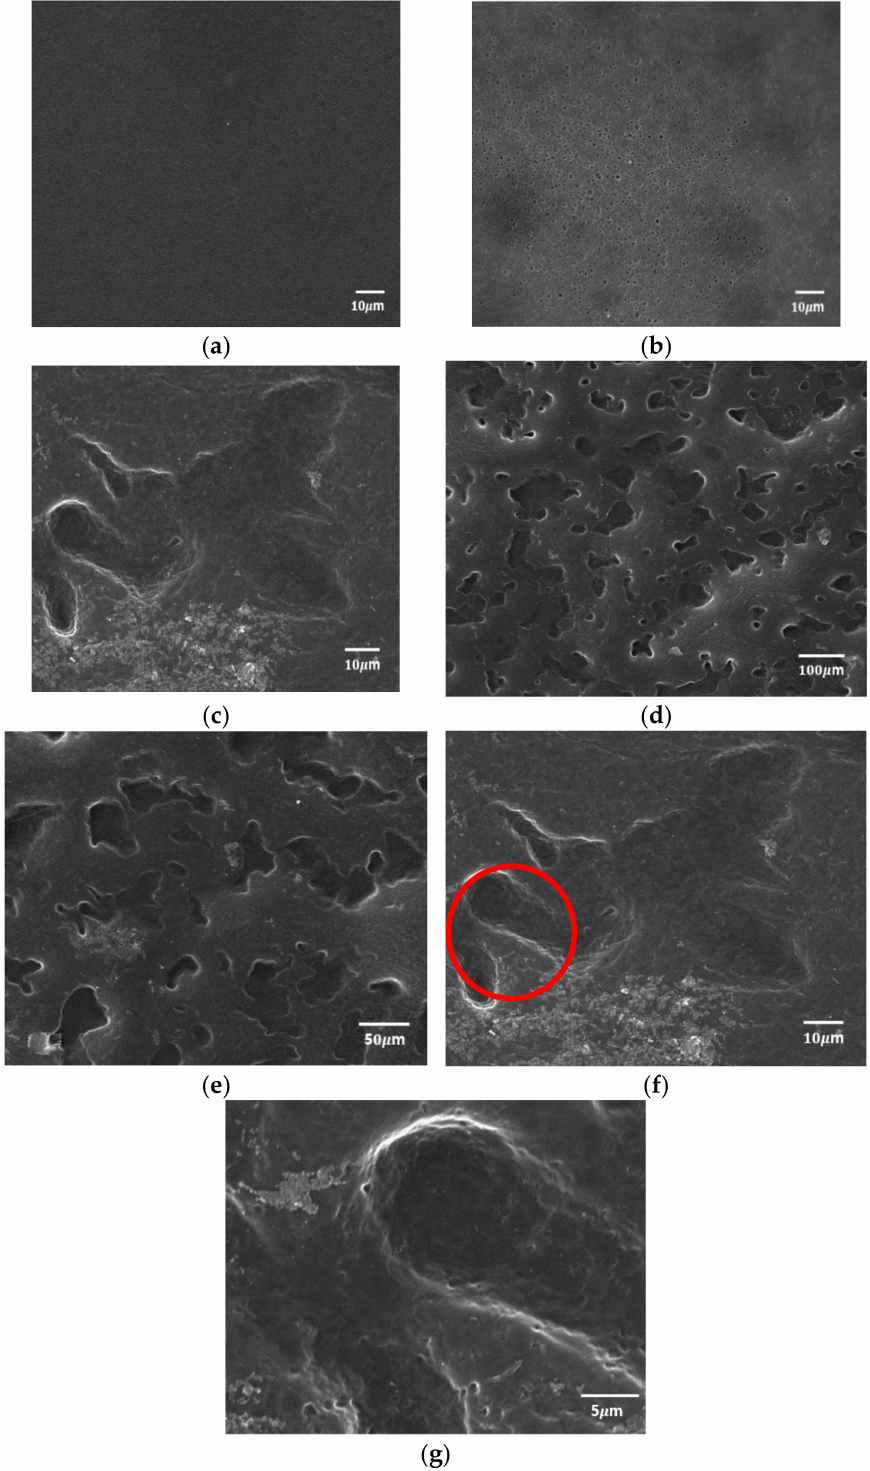
Figure 1. Scanning electron microscopy (SEM) images of the ( a ) neat cellulose acetate (CA), ( b ) mem- brane fabricated using the 1:0.2 CA/propylene glycol dissolved in acetone/water (8:2 wt/wt) before the water pressure treatment, ( c ) membrane fabricated using the 1:0.2 CA/propylene glycol dissolved in acetone/water (8:2 wt/wt) after the water pressure treatment (8 bar), the membrane fabricated using the 1:0.2 CA/propylene glycol dissolved in acetone/water (8:2 wt/wt) after applying the water pressure treatment (8 bar), ( d ) magnifications: × 140 and ( e ) magnifications: × 300. Magnified images of the areas within the red circles in ( e ) is ( f ) and red in ( f ) is ( g